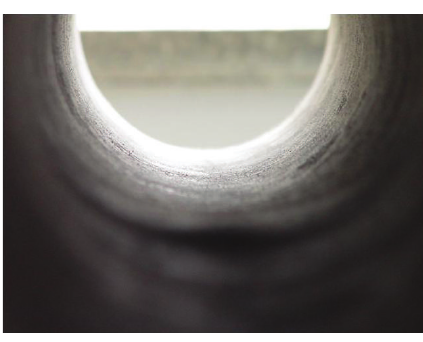
Figure 11: The casing after MMM